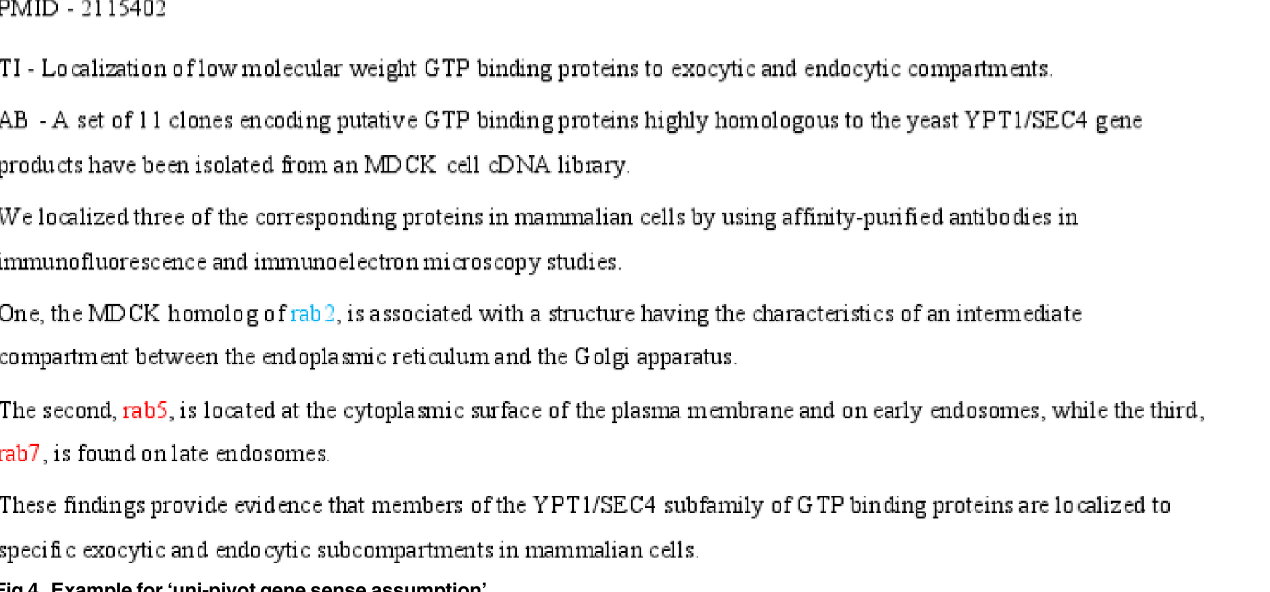
Fig 4. Example for ‘ uni-pivot gene sense assumption ’